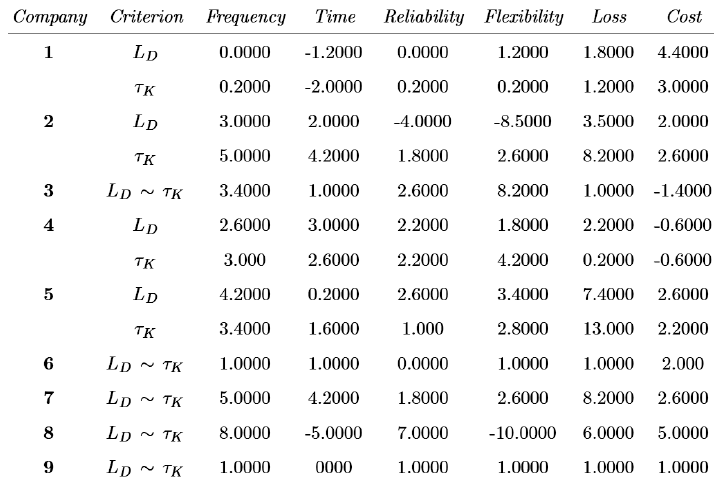
Values taken by  parameters for each